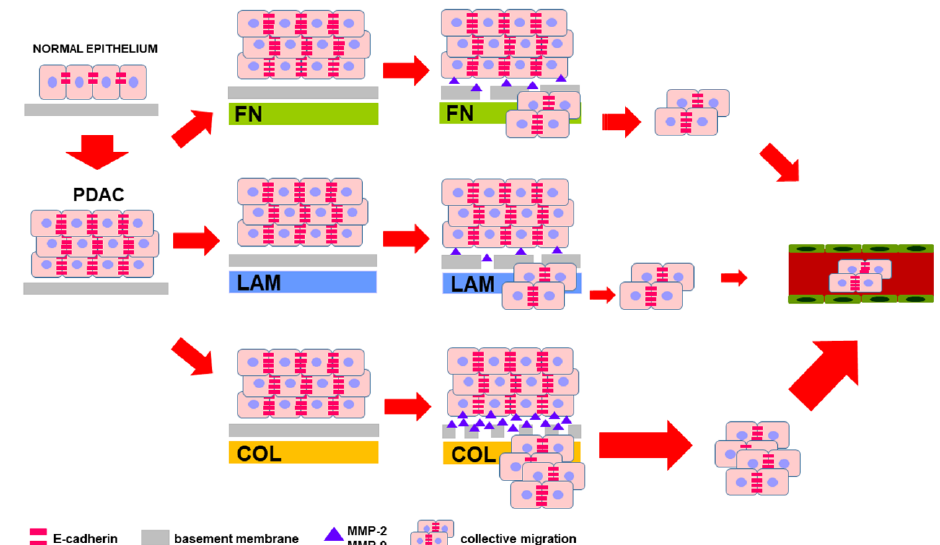
Figure 7. Extracellular matrix (ECM) components differentially affect pancreatic ductal adenocarcinoma (PDAC) cell migration and invasive properties. Diagram summarizing the hypothesis based on the most striking characteristics of PDAC cells grown on different ECM components used as a substrate. High-level expression of E-cadherin at cell boundaries is preserved and allows collective cell migration and invasion, favored by COL occurring in the pancreatic tumor microenvironment (TME), which stimulates both migration and secretion of MMPs.